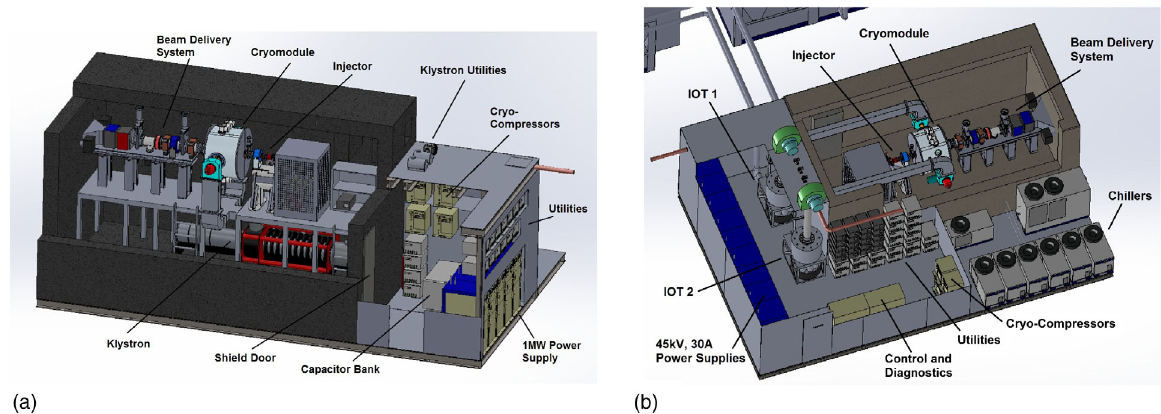
FIG. 26. Interior layouts of the commercial facility with CPI klystron (a) and MBIOTs